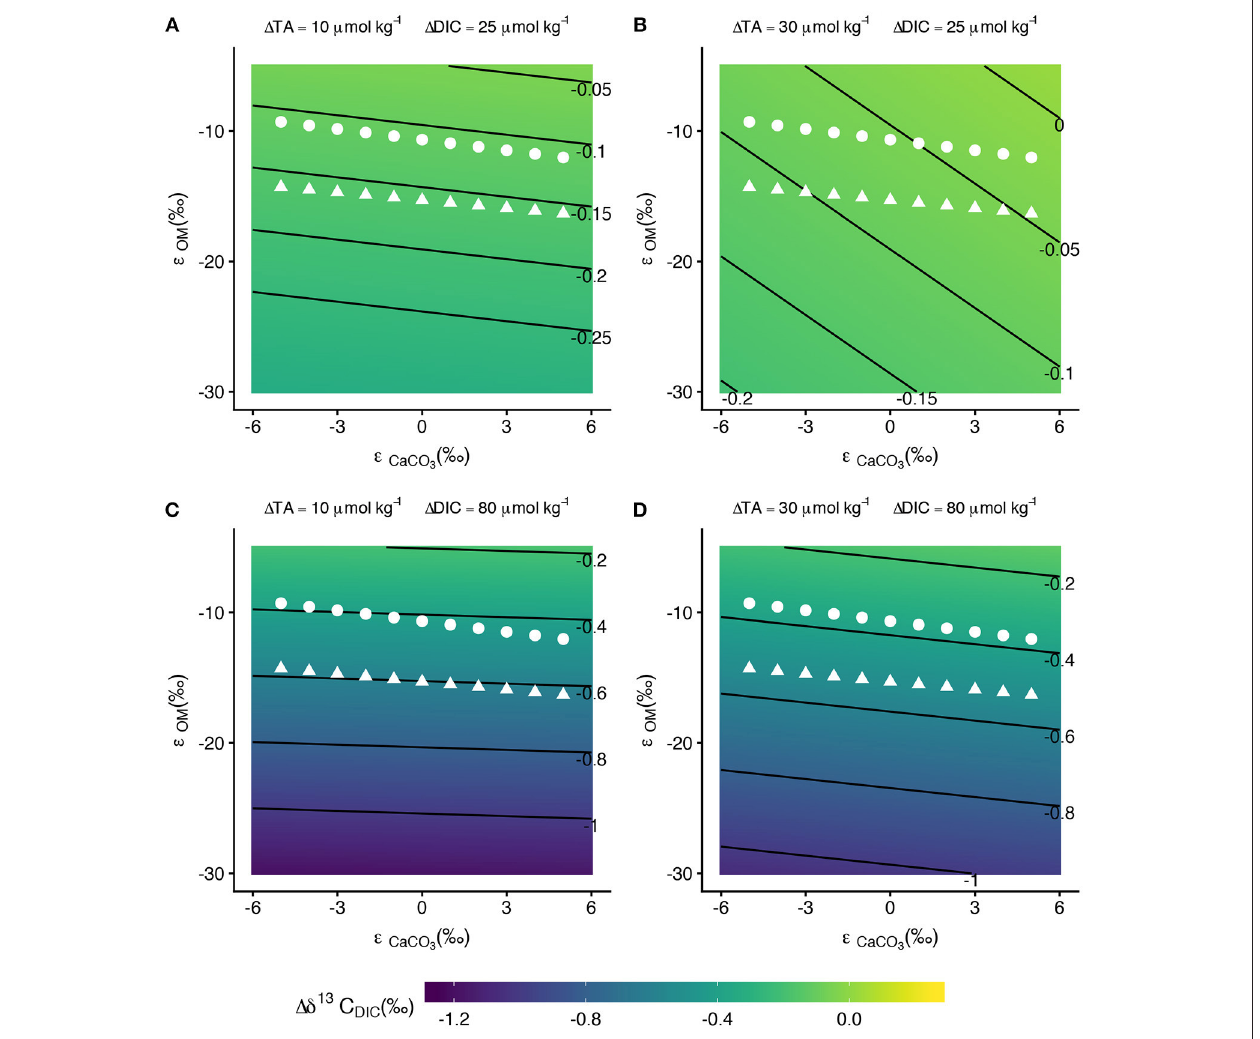
and ǫ OM for different values of 1 TA and 1 DIC . The white points on the plots show the mean ǫ OM FIGURE 9 | Contour plots of 1δ 13 C DIC as functions of ǫ CaCO 3 values from bootstrapping at selected ǫ CaCO values for the front zone (triangles) and back zone (circles). Contours lines in (A,B) are spaced by 0.05 ‰ while contour 3 lines in (C,D) are spaced by 0.2 ‰ . With the exception of high 1 TA and low 1 DIC (B) , 1δ 13 C DIC is relatively insensitive to ǫ CaCO